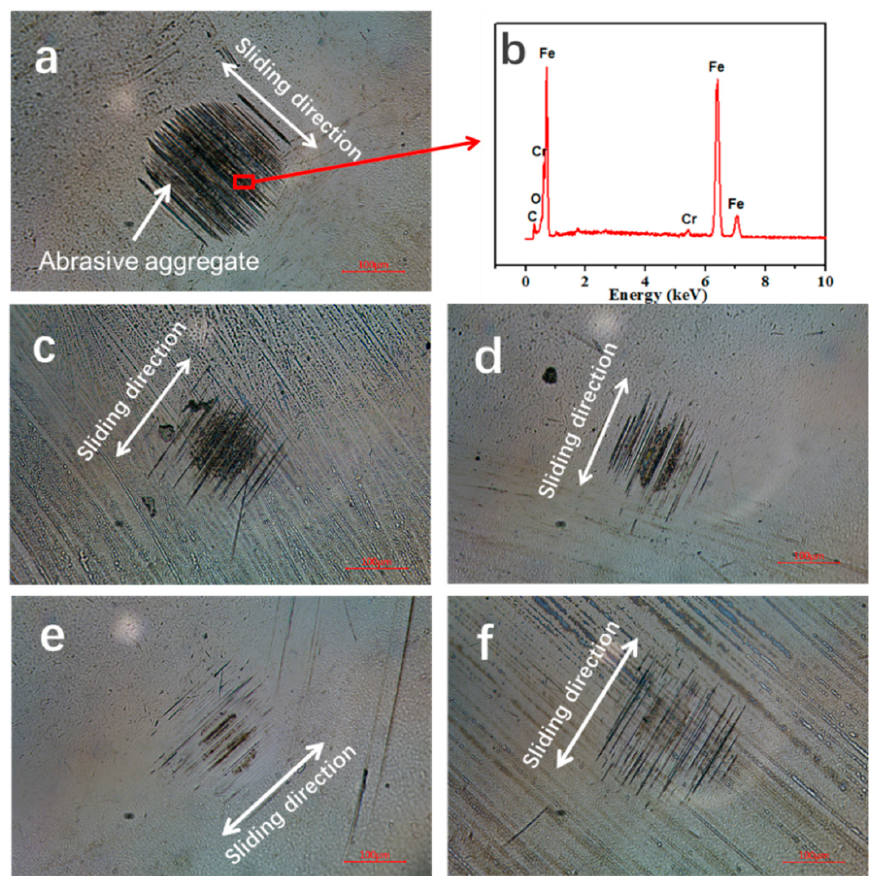
Figure 4. ( a ) The ball wear scar map pure base oil; ( b ) EDS pattern of pure base oil; ( c ) 0.1 wt.% MoS 2 QDs; ( d ) 0.2 wt.% MoS 2 QDs; ( e ) 0.3 wt.% MoS 2 QDs; ( f ) 0.5 wt.% MoS 2 QDs.